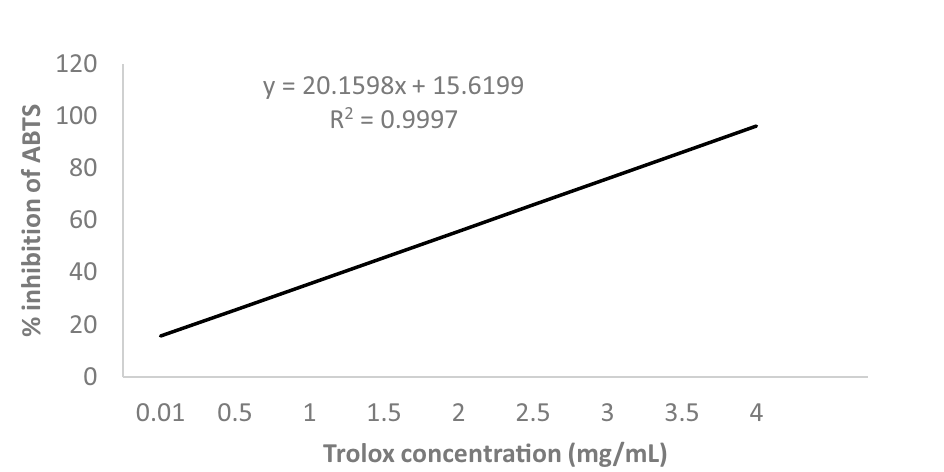
Figure 9. Calibration curve of the % inhibition of ABTS by Trolox versus the applied concentration